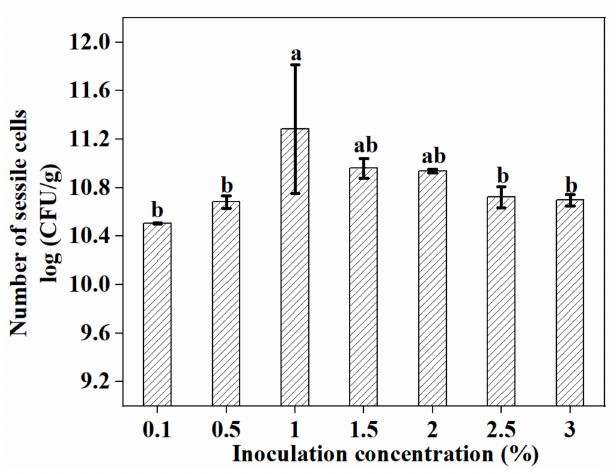
Figure 8. The effect of inoculation concentration on the number of sessile cells. Significant differences ( p < 0.05) are indicated by different letters (a and